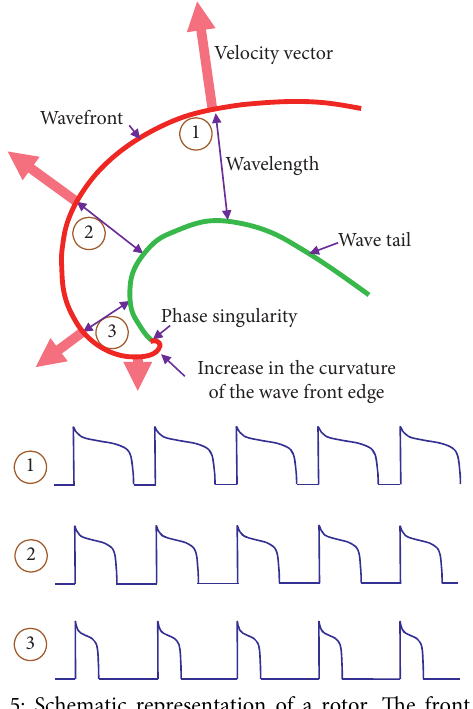
Figure 5: Schematic representation of a rotor. The front of the depolarization wave (red line) propagates at a higher speed in the periphery (point 1) than in the center (point 3). The green line represents the repolarized edge. The wavelength, the refractoriness, and the conduction velocity differ from the periphery to the center; however, the depolarization frequency in a stable rotor is the same (see text for